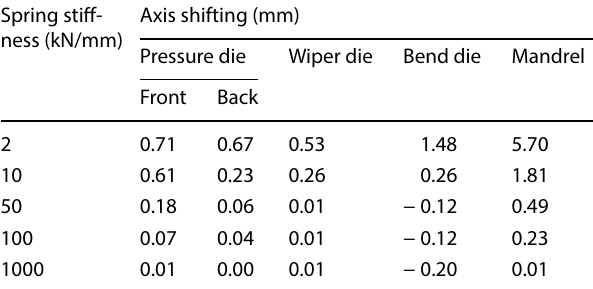
Table 1 Axis shifting with a pressure die distance of 0 mm Spring stiff- Axis shifting (mm) ness (kN/mm)